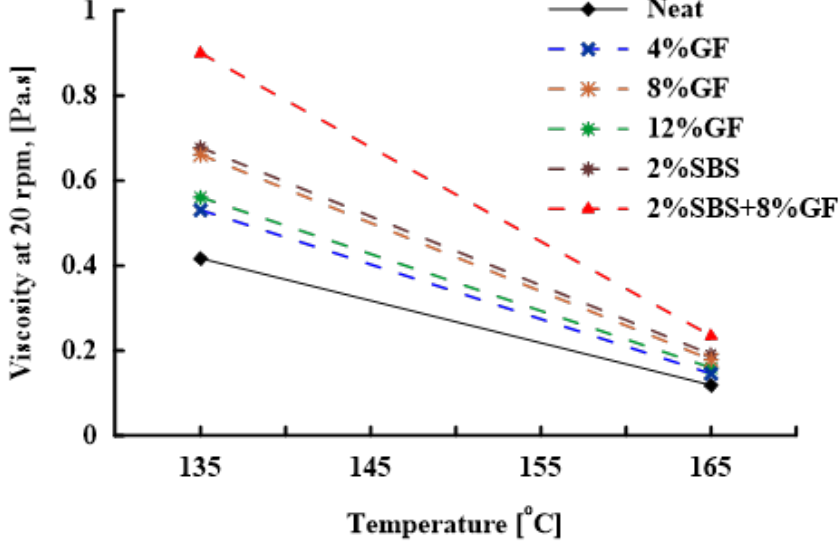
Figure 2. Rotational viscosity of neat and modified asphalt binders.